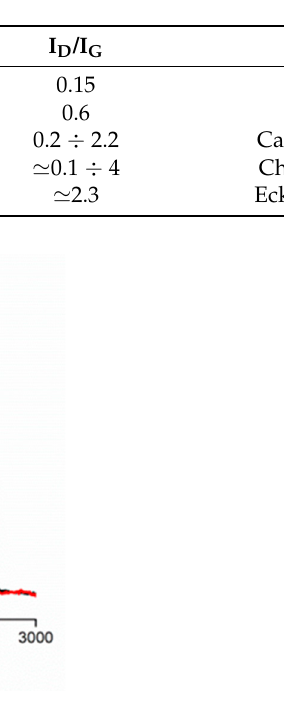
Figure 3. Raman spectra of an unirradiated MLG (black line) and irradiated (red line) MLG by 30 keV (Ar n ) + , where n ≈ 1000, cluster ions at a dose of 10 14 ion/cm 2 .